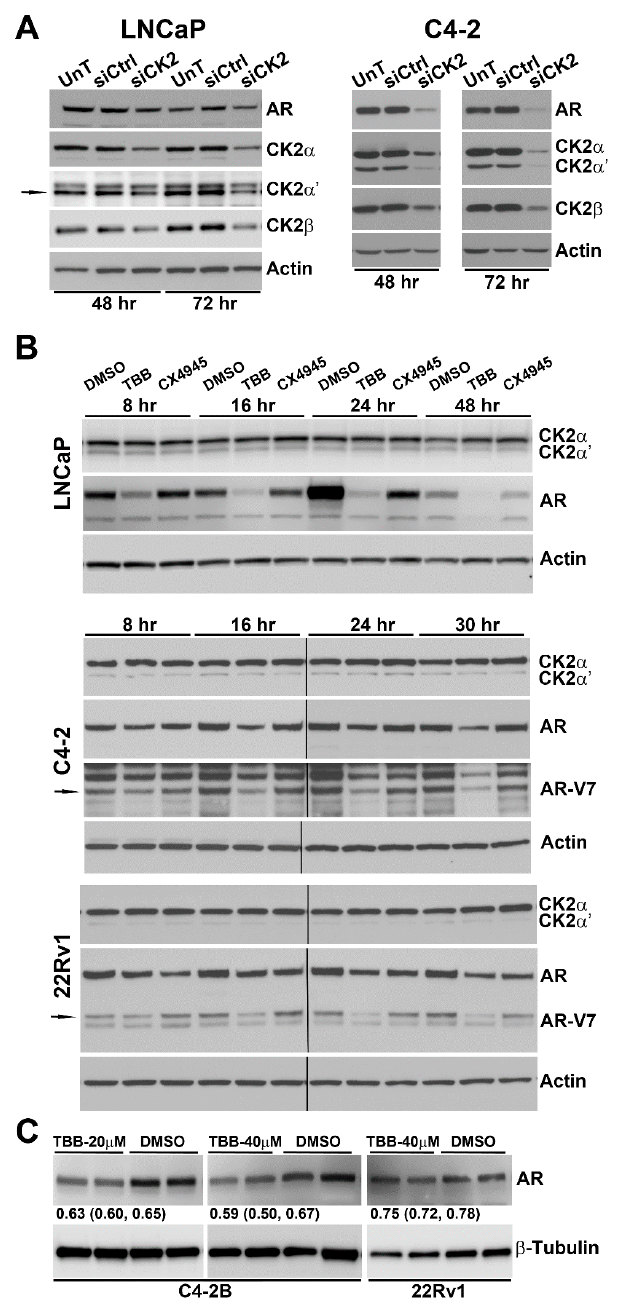
Figure 3. Blocking CK2 expression and activity reduces AR protein levels in PCa cells. ( A ) LNCaP (left panels) and C4-2 (right panels) cells were transfected with CK2 αα ’-targeted and control siRNAs. Cells were collected 48 and 72 h post-transfection for analysis by immunoblot. ( B ) LNCaP, C4-2, and 22Rv1 cells were treated with 80 µ M TBB, 10 µ M CX-4945, or equivalent concentration of DMSO. Cells were collects at various time points, as labeled above the lanes, for analysis by immunoblot. UnT = untreated cells. Vertical lines indicate non-contiguous lanes. ( C ) C4-2B and 22Rv1 cells were treated with 20 µ M TBB, 40 µ M TBB, or equivalent concentration of DMSO. Cells were collected at 24 h for analysis by immunoblot. Mean and 95% confidence intervals for AR protein levels after TBB treatment relative to DMSO treatment are indicated below the AR bands. For all panels: Proteins detected are indicated on the right side of blots, time points analyzed are indicated below the blots, and either actin or β -tubulin were used as loading controls. Arrows indicate correct